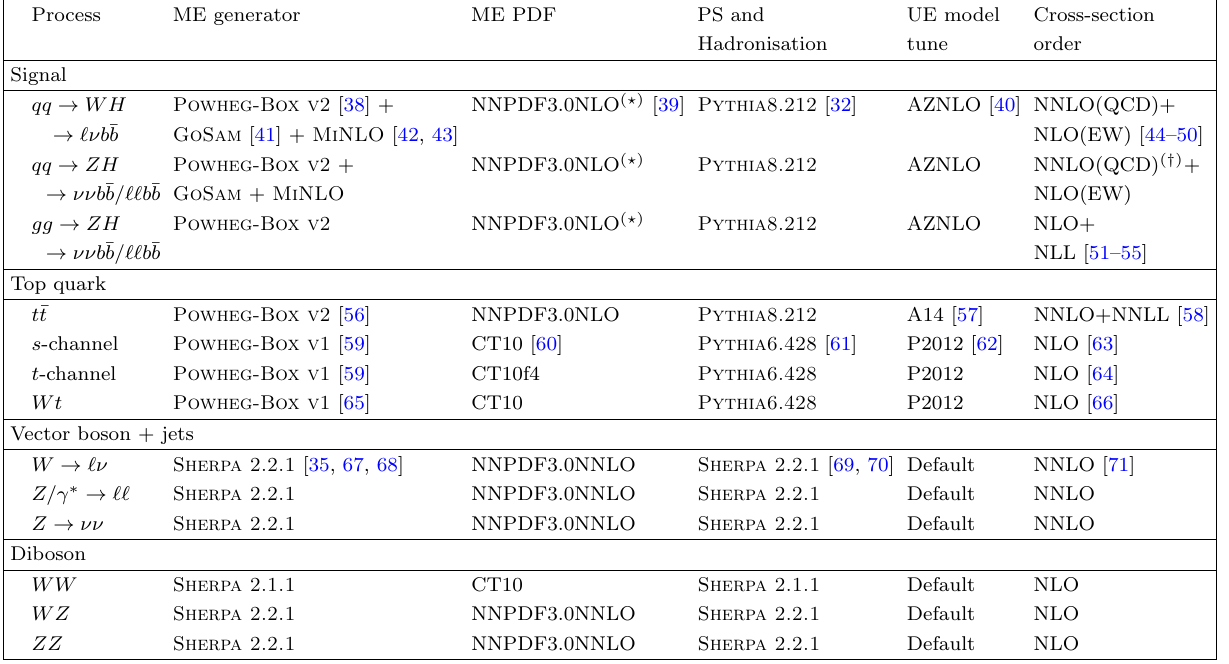
Table 1 . The generators used for the simulation of the signal and background processes. If not speci(cid:12)ed, the order of the cross-section calculation refers to the expansion in the strong cou- pling constant ( (cid:11) S ). The acronyms ME, PS and UE stand for matrix element, parton shower and underlying event, respectively. ( ? ) The events were generated using the (cid:12)rst PDF in the NNPDF3.0NLO set and subsequently reweighted to PDF4LHC15NLO set [37] using the internal algorithm in Powheg-Box v2 . ( y ) The NNLO(QCD)+NLO(EW) cross-section calculation for the pp ! ZH process already includes the gg ! ZH contribution. The qq ! ZH process is normalised using the NNLO(QCD)+NLO(EW) cross-section for the pp ! ZH process, after subtracting the gg ! ZH